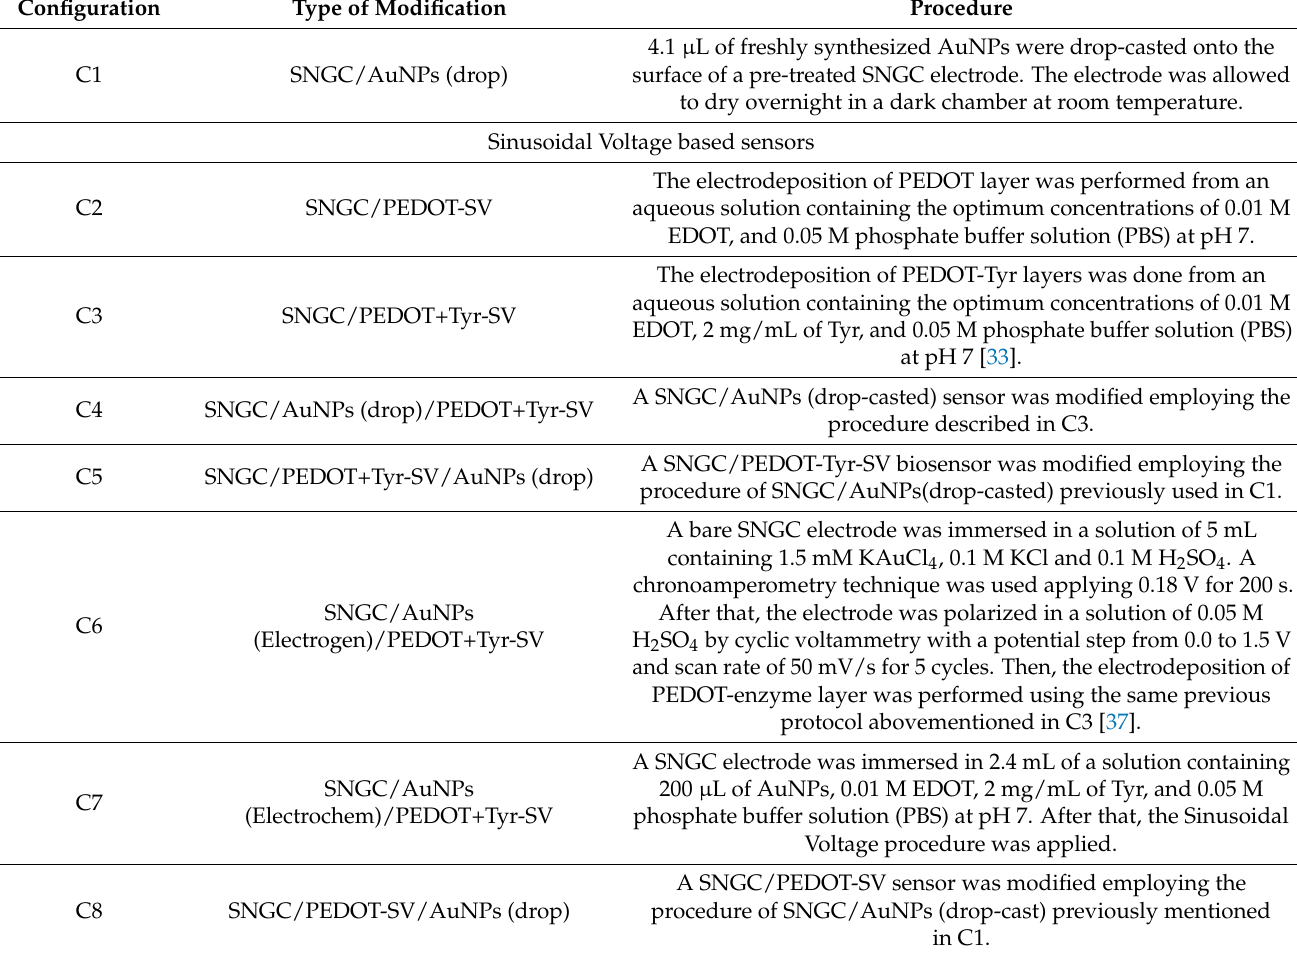
Table 1. Different modification conditions performed on the SNGC